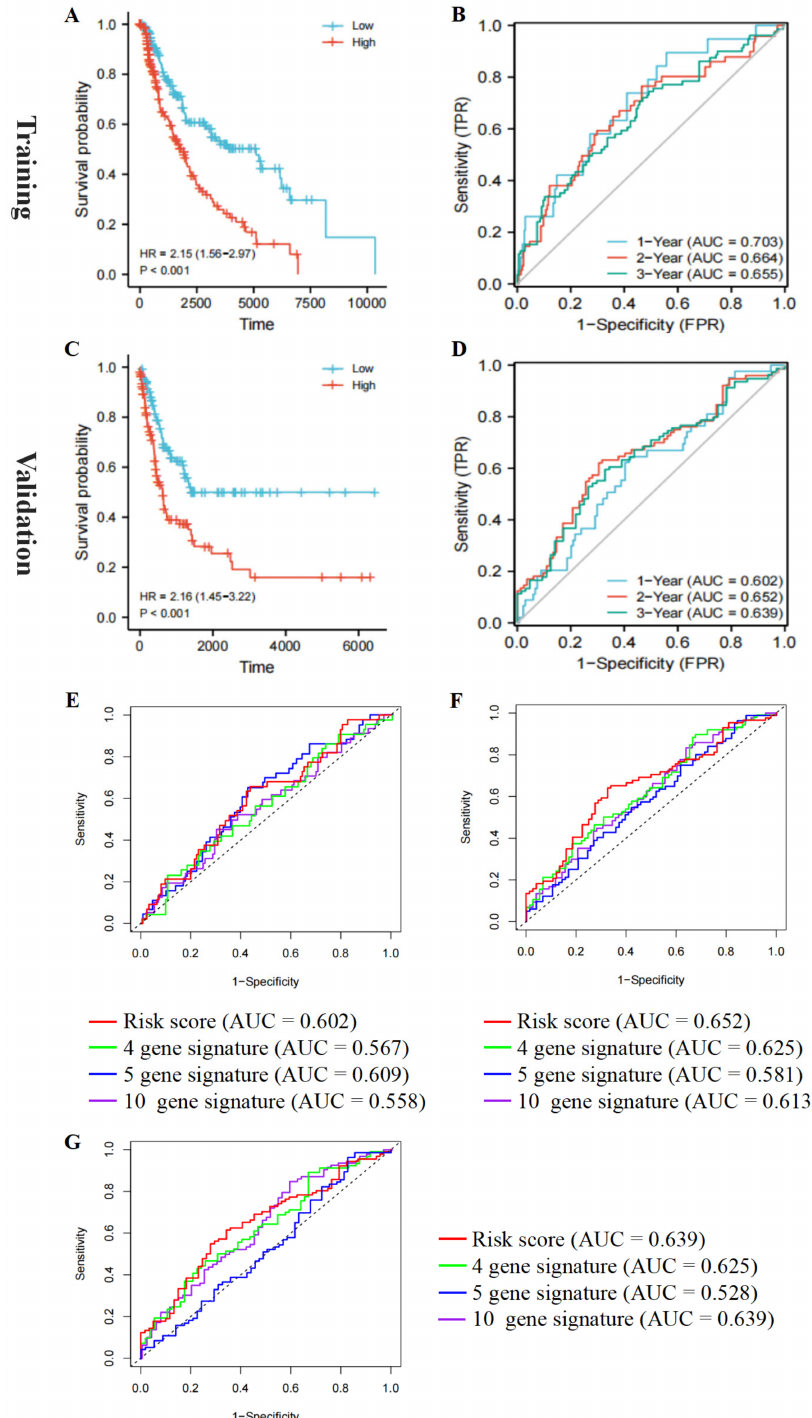
Figure 7. Validation of the prognostic risk signature. ( A ) In the training group, the OS of the two groups separated according to the median of risk scores of the prognostic risk signature was assessed. ( B ) The ROC curve was used to assess the prognostic feature predictive efficiency in the training group. ( C ) In the validation group, the OS of the two sets separated according to the median of risk scores of the prognostic risk signature was assessed. ( D ) The time-dependent ROC curve was used to evaluate the prediction efficiency of the prognostic model in the validation cohort. ( E – G ) The 1-year, 2-year, and 3-year AUC values of our RBM38-related immune signature were compared with the other three confirmed signatures of